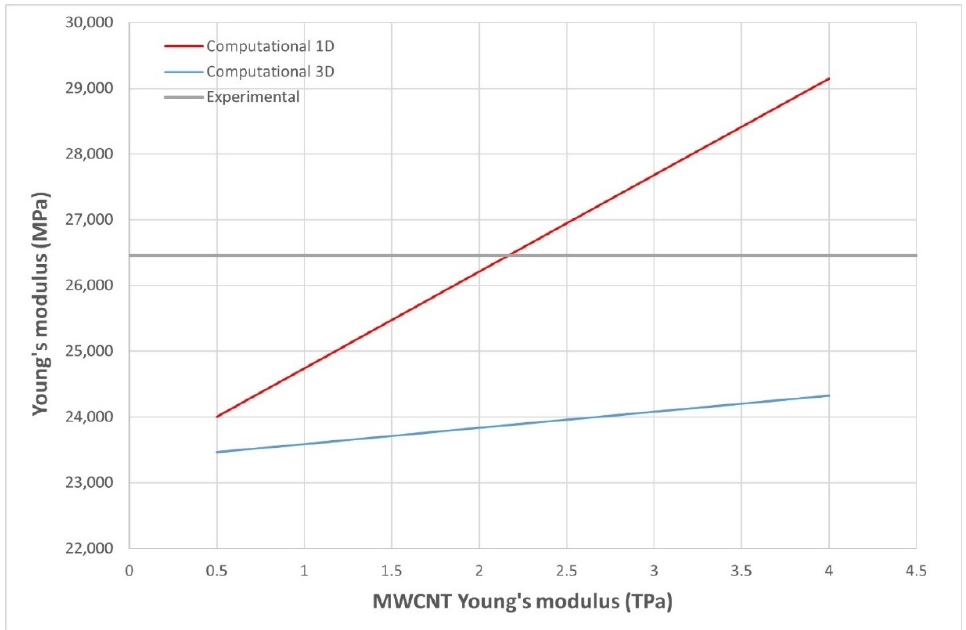
Figure 7. Young’s modulus for the 0.1 MWCNT composite, varying the MWCNT Young’s modulus in the range of the experimental measured values (shown in Table